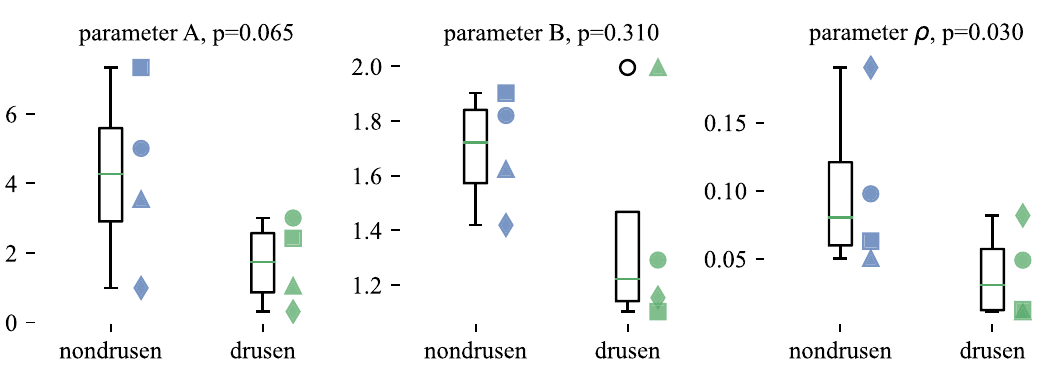
Figure 8. Differences in fitting parameters between non-drusen and drusen zones. After fitting each subject’s non-drusen and drusen IS/OS amplitude to Gaussian functions of effective pupil position, the resulting parameters for Gaussian amplitude, bias, and directionality (width) were pooled across subjects and tested for differences due to zone. While all three parameters had greater values in non-drusen zones compared to drusen zones, only the difference in directionality (Gaussian width) ρ was statistically significant ( p = 0.03 ). The difference in Gaussian amplitude A was marginally significant ( p = 0.065 ), and the difference in Gaussian bias B was not significant ( p = 0.31 ). The p values shown above were somewhat sensitive to parameters in